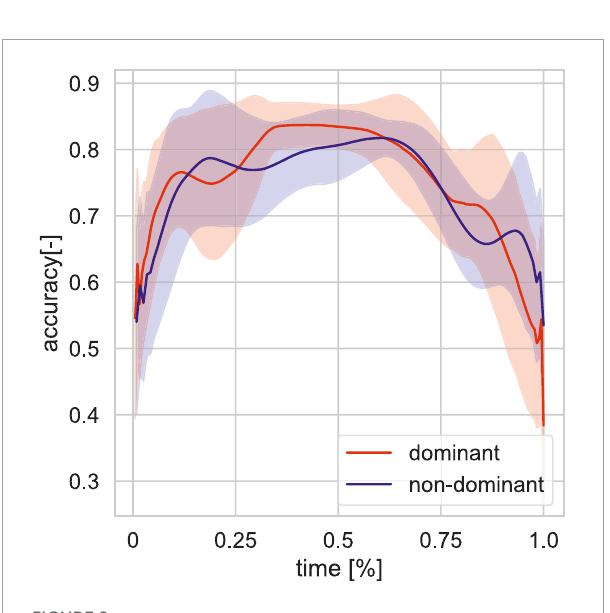
FIGURE 2 Averaged pointing accuracy profile for front targets in training set for the dominant and non-dominant